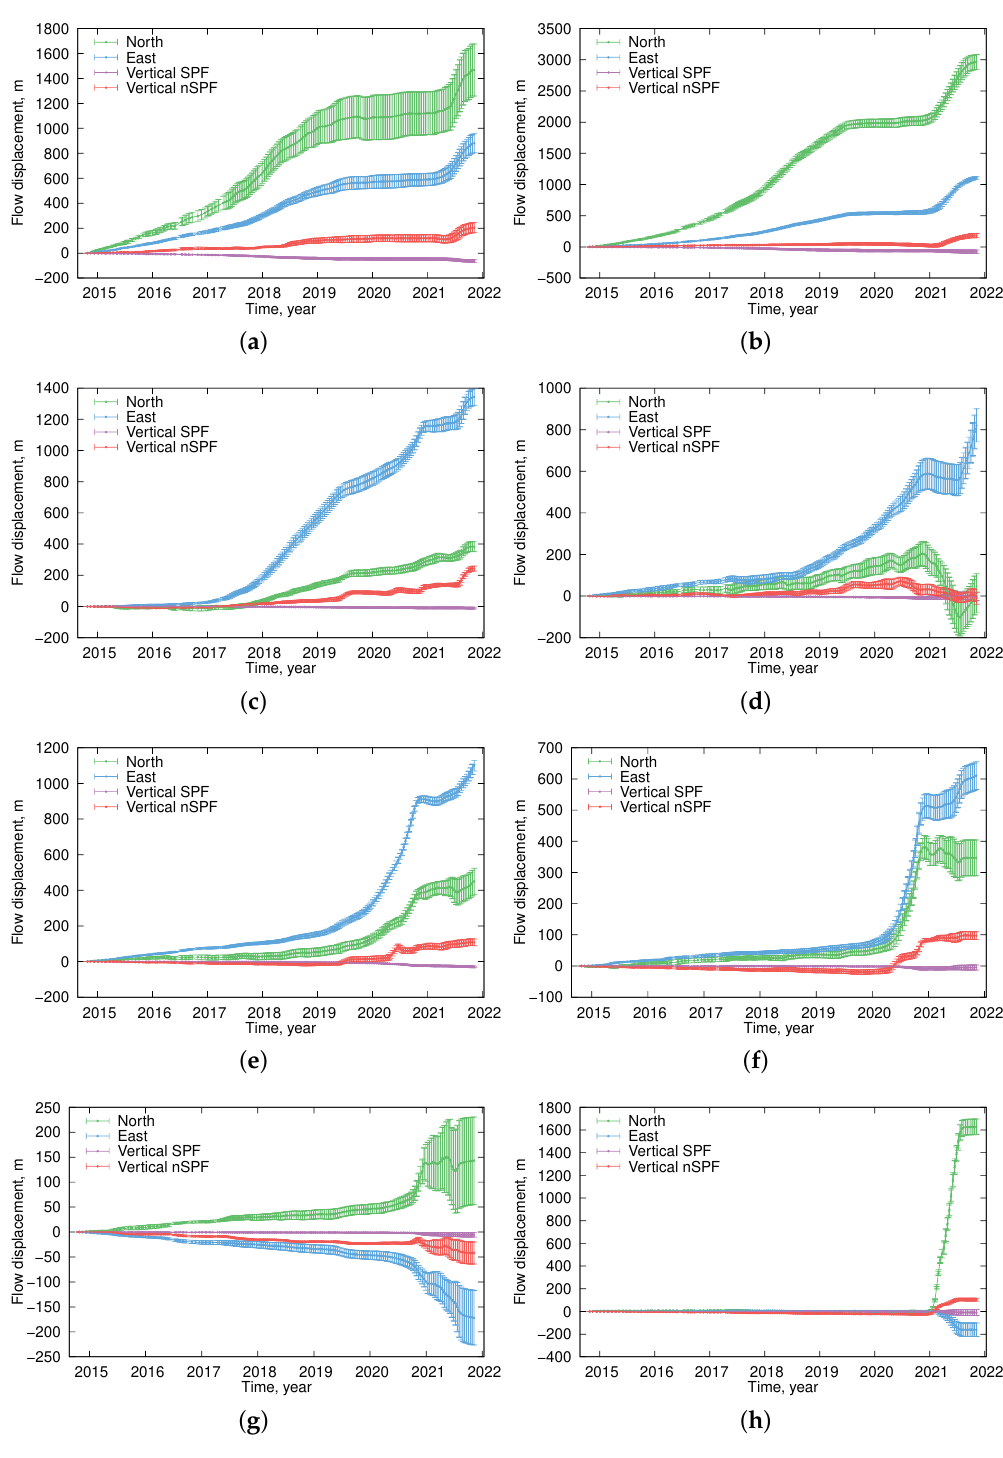
Figure 8. 4D flow displacement time series for ( a ) 5, ( b ) 10, ( c ) 15, ( d ) 20, ( e ) 25, ( f ) 30, ( g ) 35, ( h ) 40 km markers along central flowline of Muldrow